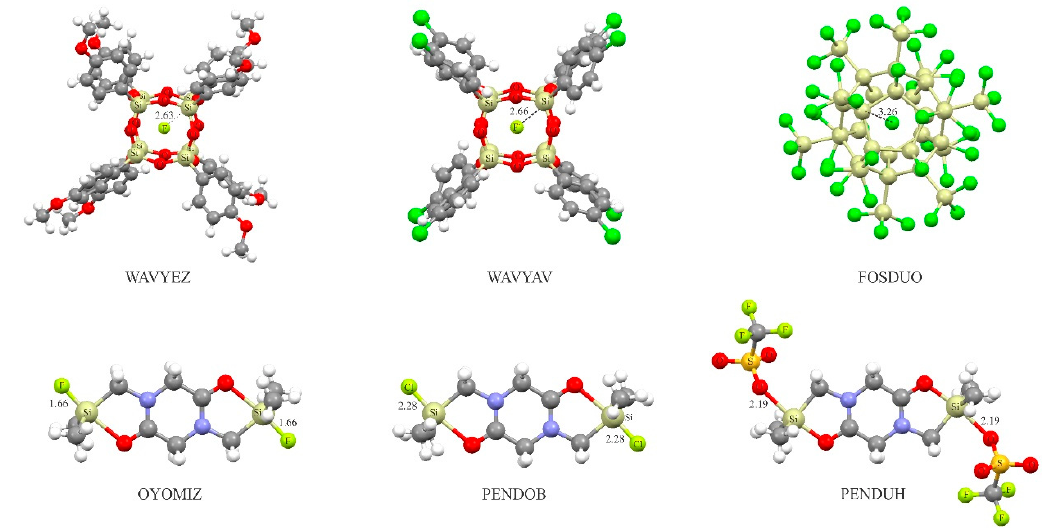
Figure 7. Crystalline structure ofsome selectedanionic tetrel-bonded complexes.